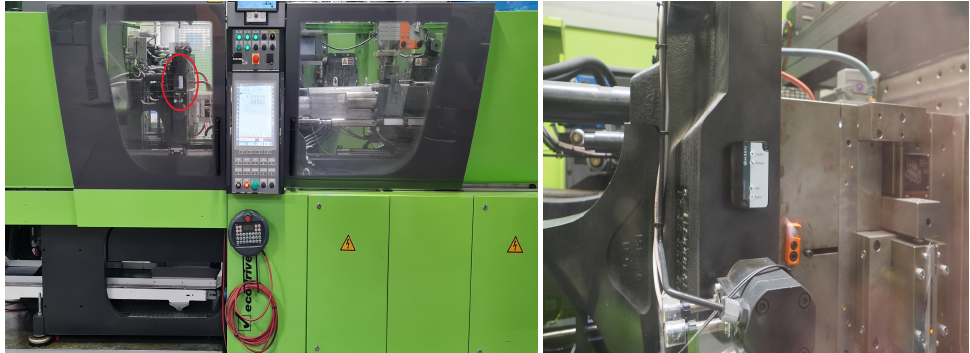
Figure 1. The left image shows an injection molding machine with a mounted 3-axis accelerometer (sensor marked by a red circle in the center of the image). The right picture shows the mounting of the same sensor in